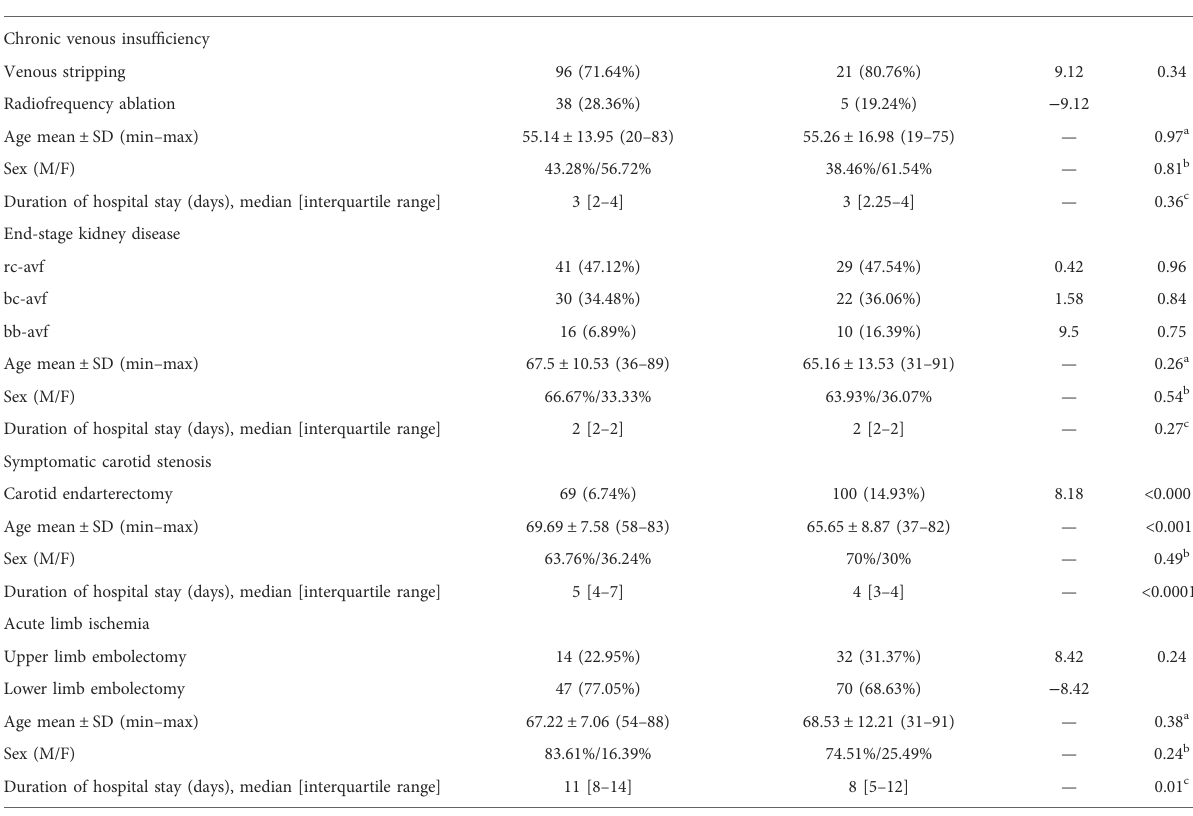
TABLE 3 Types of surgeries and their characteristics for both periods — part